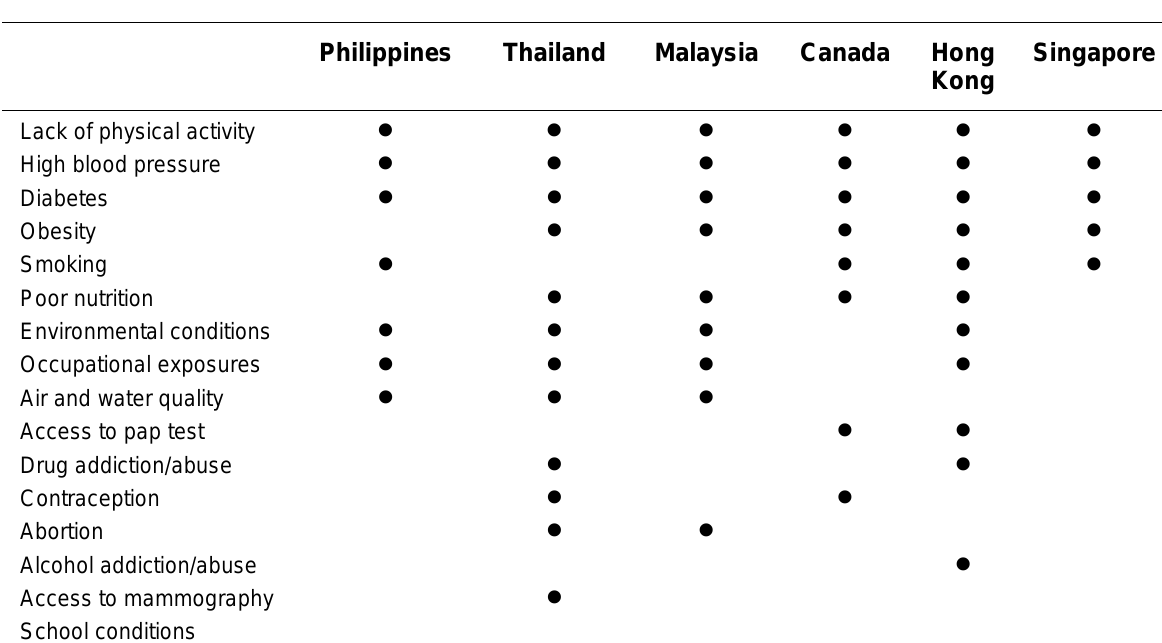
Opinion on Important Risk Factors (Biological and Physical) Affecting Women’s Health, According to Key Informants During Interview, by